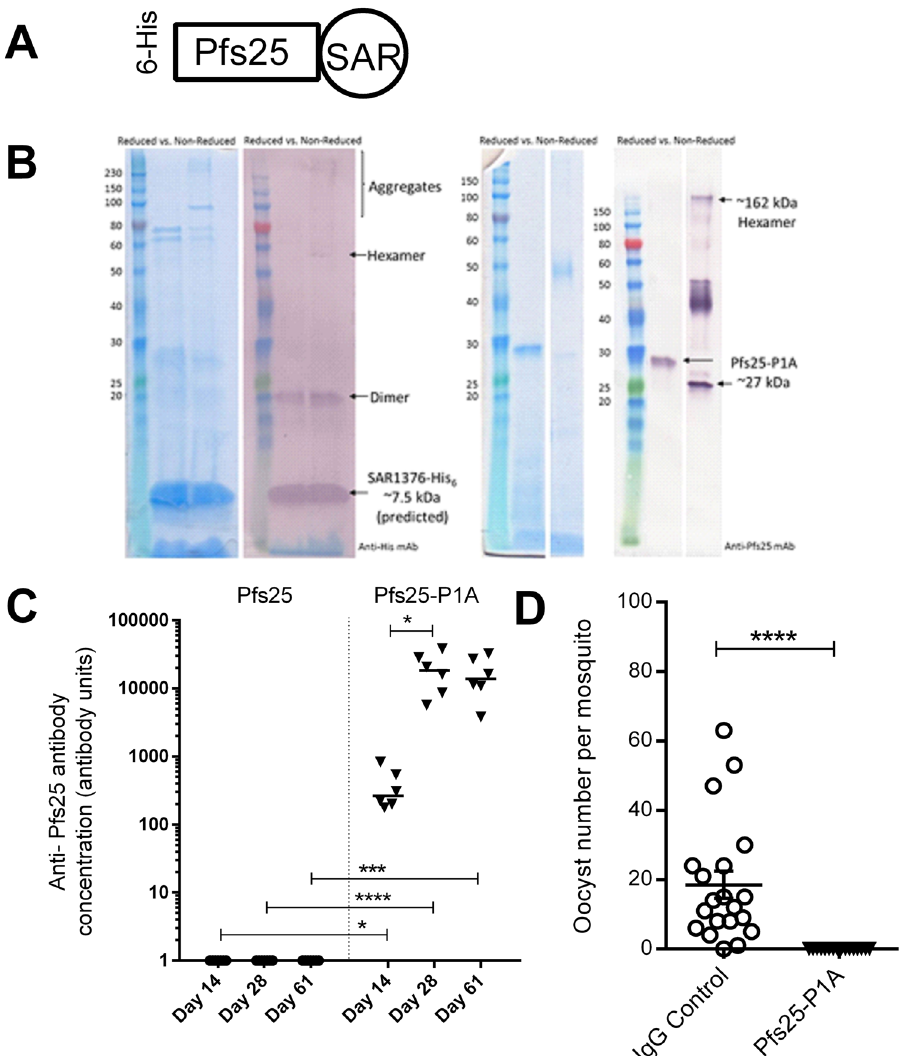
and Pfs25-SAR1376-P1A (anti Pfs25 mAb). ( C ) Antibody response after vaccination of BALB/c mice with monomeric Pfs25 or Pfs25 fused to SAR1376-P1A. Sera were collected at day 14, 28 and day 61 post prime and IgG responses measured using a standardised ELISA. Each solid symbol represents a single mouse. ( D ) Pooled-purified IgG mixed with P . falciparum gametocytes was fed to Anopheles stephensi mosquitoes through a membrane. Midguts were dissected 9 days post-feed and the number of oocysts per gut were counted. Each symbol represents the count from one mosquito. AU = antibody units. * p < 0.05; *** p < 0.001; **** p <